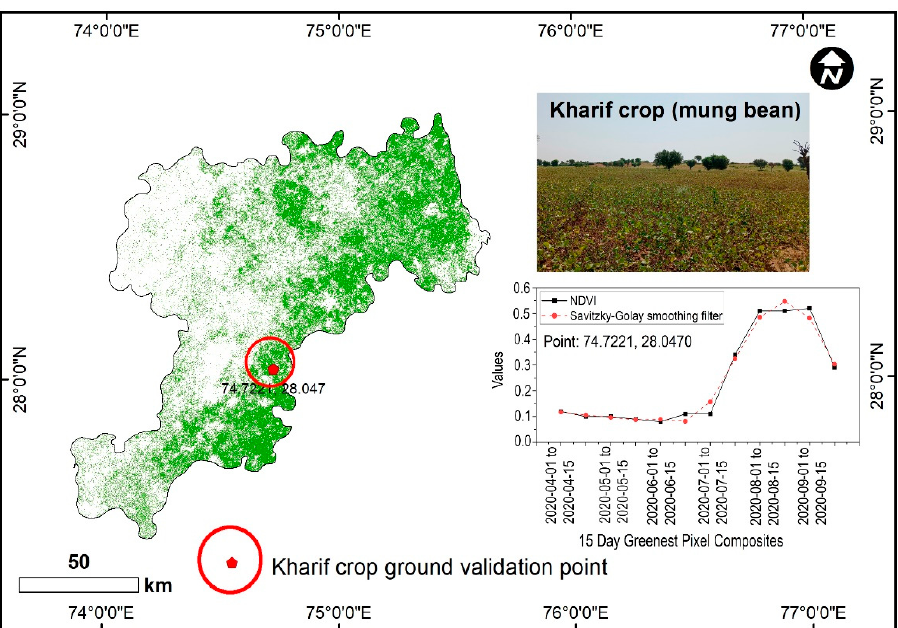
Figure 13. Kharif crop ground validation point example with photograph (Datum: WGS84).